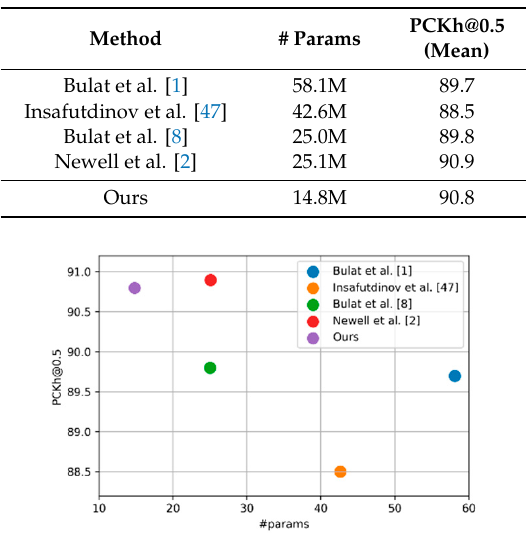
Figure 7. Visualization of performance versus number of parameters among studies using the MPII dataset.